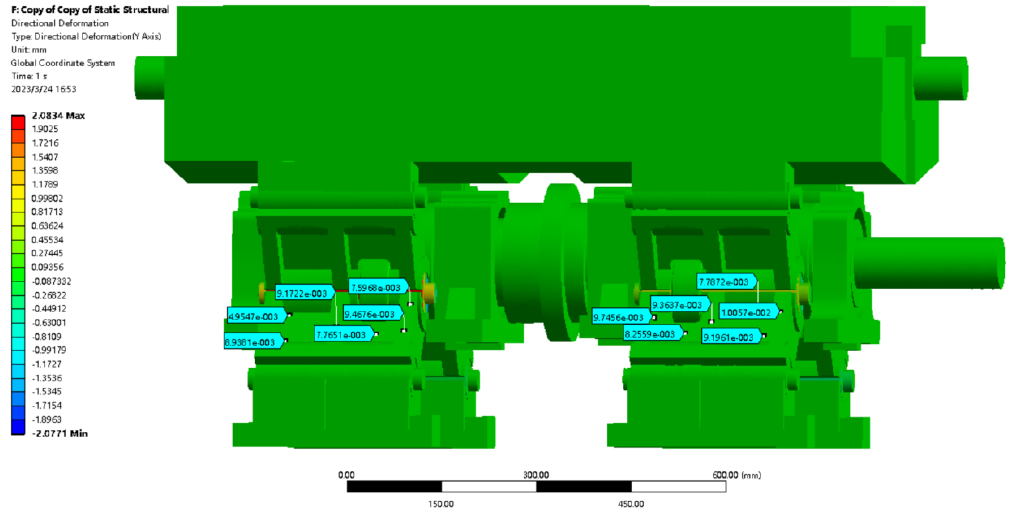
Figure 33. The deformation result diagram of the drive rod in the assembly.